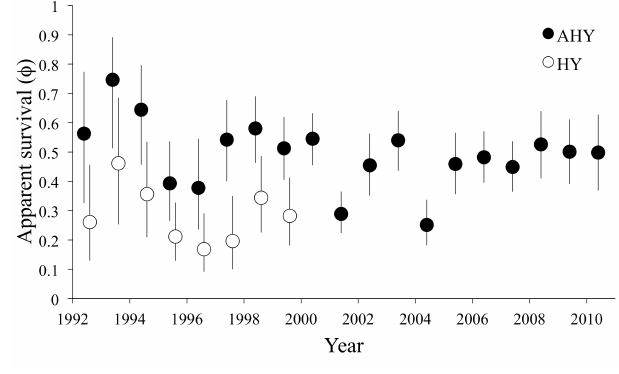
Fig. 2 . Annual probabilities of apparent survival for hatch-year (HY-open circles) and after-hatch-year (AHY-solid circles) male Golden-cheeked Warblers ( Setophaga chrysoparia ) on the Fort Hood Military Reservation, Texas, USA. For AHY birds, apparent survival ( Φ ) varied across time, and resight probability ( p ) differed among study plots ( Φ p ). For HY birds, Φ varied t, sp additively between age classes and across time, and p was constant ( Φ , p ). Error bars are 95% confidence a+t .